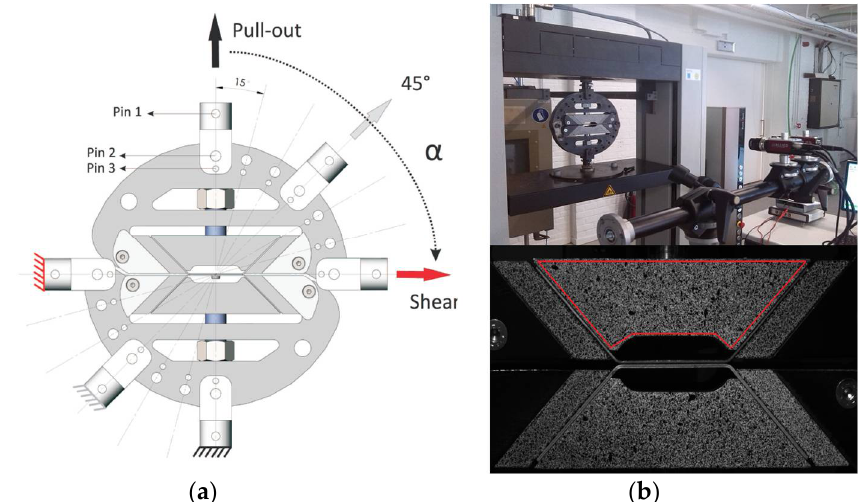
Figure 2. Modified Arcan device overview: ( a ) Device overview ( b ) Experimental set-up (upper) and the attached speckle pattern (lower).